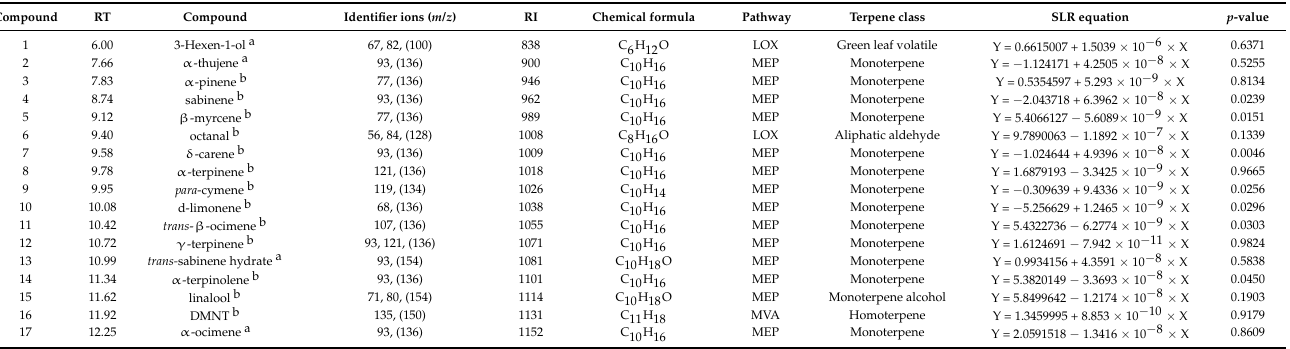
Table 1. Volatile organic compounds (VOCs) from hexane-extracted leaves of C. macrophylla and their GC-MS chromatographic parameters, terpene class and biosynthetic pathway. Simple linear regression was performed using the peak areas of each compound in C. macrophylla leaf extracts with a gradient of the photobleaching (control, mild, medium, and strong) phenotype.